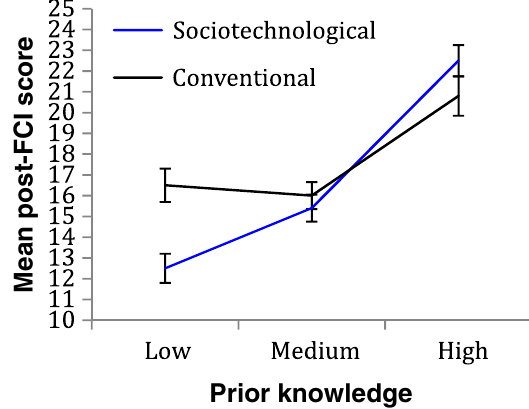
FIG. 3. Students in active learning student-centered pedagogies achieve higher normalized gains than students in traditional teacher-centered instruction regardless of whether they have low, medium, or high prior knowledge. Error bars represent the standard error to the mean.